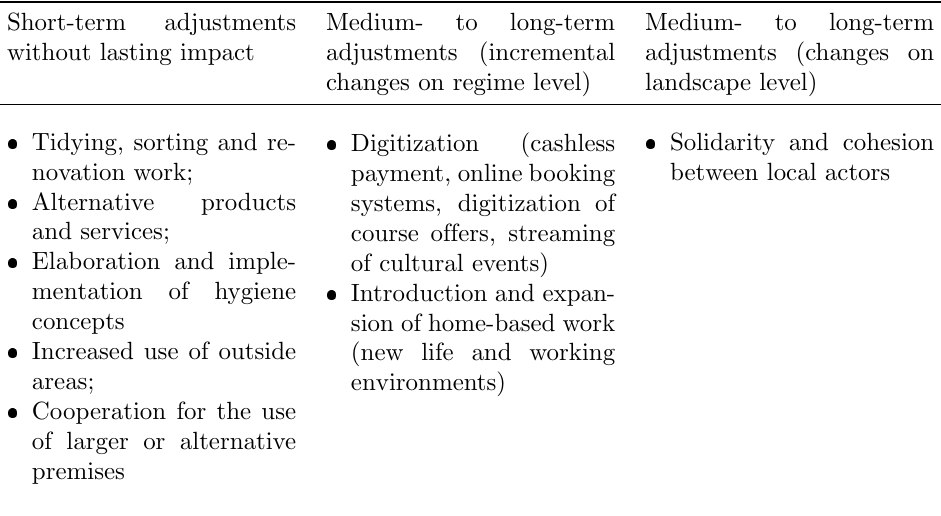
Table 4: Windows of Opportunity according to their temporal consistency and level (MLP) Short-term adjustments without lasting impact